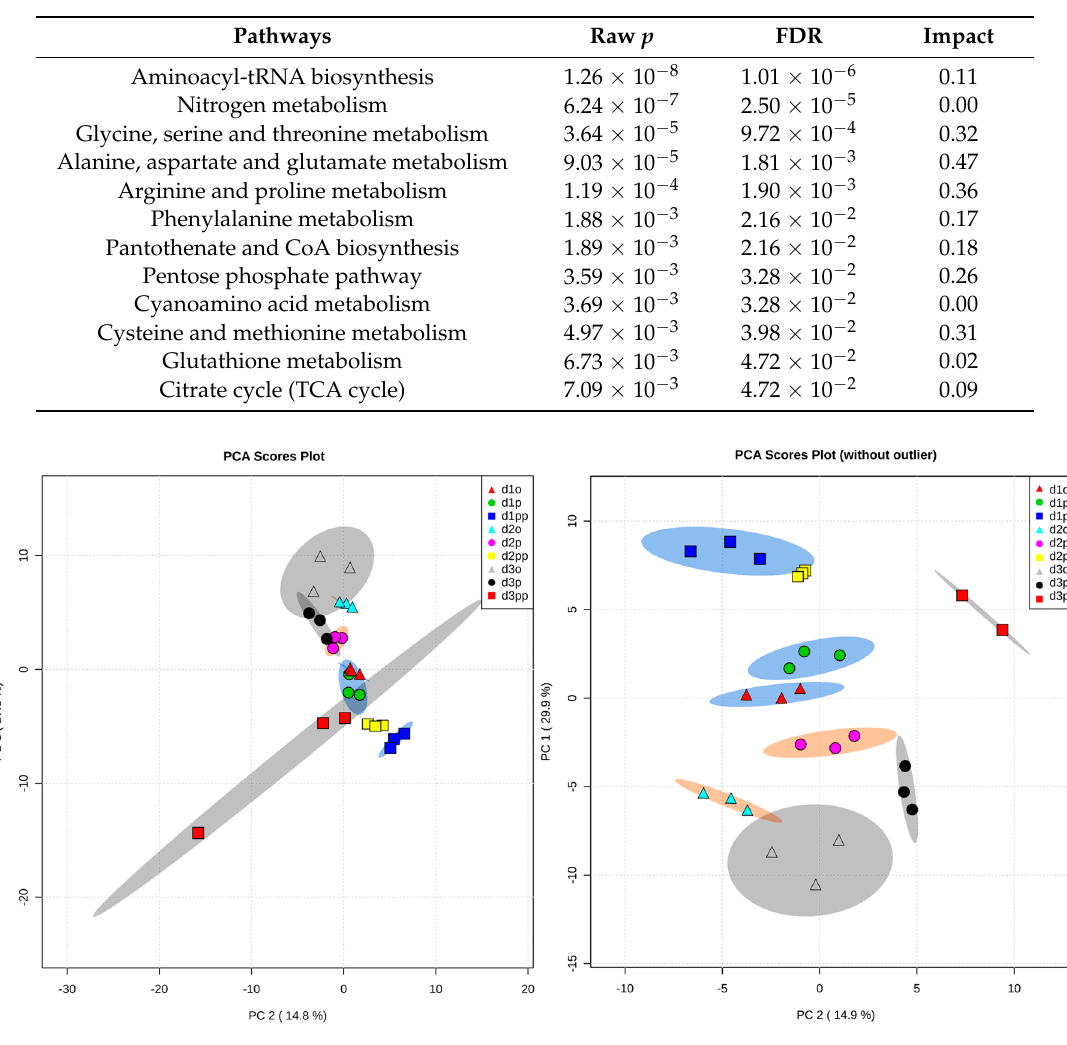
Figure A1. PCA scores plots before ( left ) and after ( right ) removal of outlier. After removal of outlier, all groups could be separated with PCA.